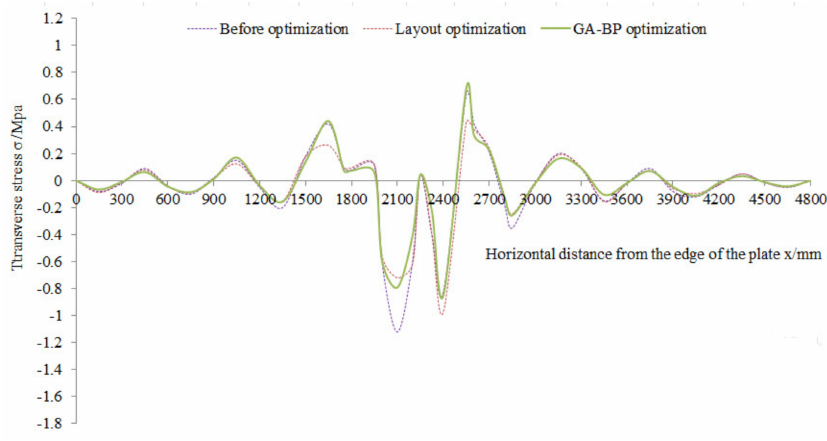
Figure 12. Comparison of the peak stress distribution of optimized pavement under load II.